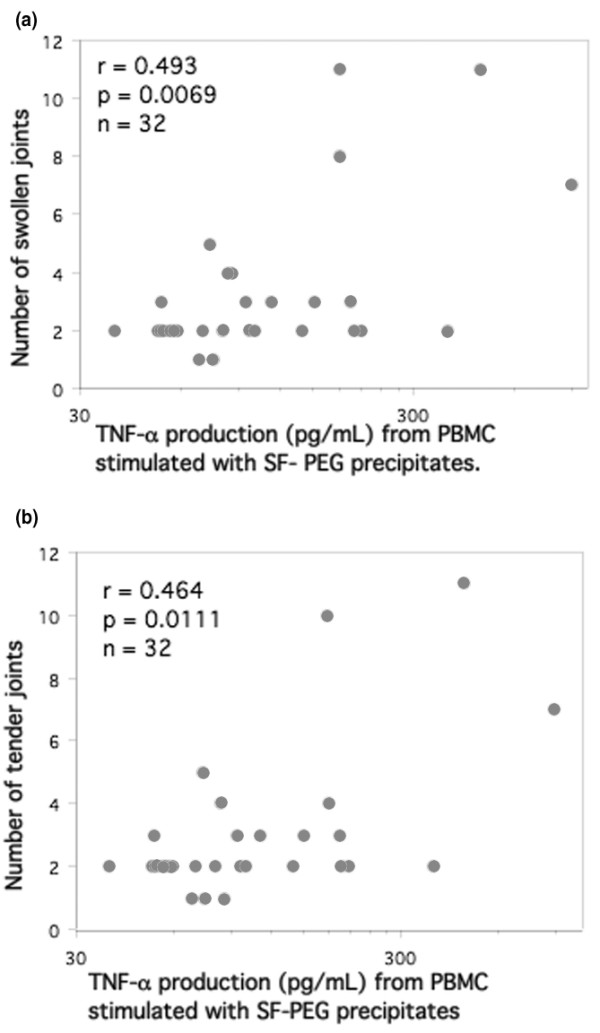
TNF-α production induced by SF precipitates correlate with the number of swollen and tender joints. PBMCs were stimulated with SF precipitates from 32 RA patients for 20 hours. TNF-α levels in the supernatants were measured using ELISA and data regarding the number of swollen and tender joints were collected from the patients' charts. The numbers of (a) swollen and (b) tender joints correlated with TNF-α production. Statistical analyses were performed with nonparametric tests to diminish the effect of outliers. ELISA, enzyme-linked immunosorbent assay; PBMC, peripheral blood mononuclear cell; RA, rheumatoid arthritis; SF, synovial fluid; TNF, tumour necrosis factor.